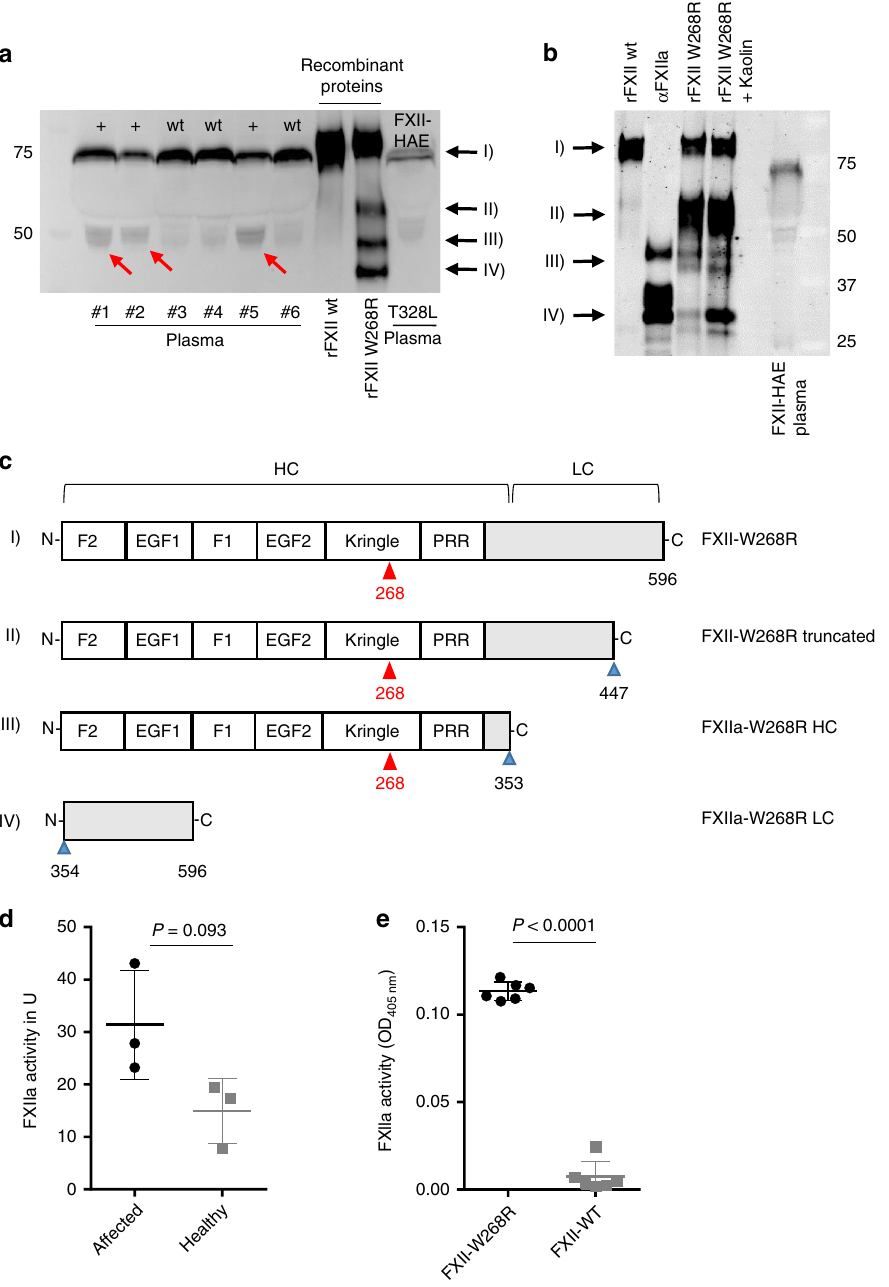
Fig. 2 FXII W268R results in fragmentation and spontaneous activation of FXII. a FXII fragmentation in FACAS plasma samples and FXII W268R mutant proteins. Citrate plasma of affected (#1, #2, #5) and non-affected (#3, #4, #6) family members, recombinant wild-type and W268R FXII expressed in HEK293 cells and plasma from an FXII-HAE patient was separated by SDS-PAGE (reducing blot) and immunoblotted for FXII. Red arrows at 50 kDa indicate heavy chain of cleaved FXII in the plasma of affected patients and recombinant W268R FXII (rFXII W268R), which is barely visible in non-affected and hereditary angioedema (HAE) III plasma or wild-type FXII (rFXII wt). Recombinant W268R and wild-type FXII were expressed in HEK293 cells. Black arrows point to rFXII W268R fragments observed by mass spectrometry in c , n = 5 technical replicates. b Immunoblot (reduced conditions) of recombinant mutant proteins (in the presence or absence of surface activator kaolin) and controls (rFXII wt and puri fi ed α FXIIa). In addition to 50 kDa (heavy chain, HC) and 25 kDa (light chain, LC) bands, a further band appears at 60 kDa (II) that is absent in rFXII wt and α FXIIa. Black arrows point to rFXII W268R fragments observed by mass spectrometry in c , n = 3 technical replicates. c Schematic presentation of FXII W268R procession. Red arrows point to mutation at position W268R. Proteolytic sites are indicated by blue arrows. Cleavage after position 353 results in FXIIa W268R HC (50 kDa) and FXIIa W268R LC (25 kDa) fragments. Additional cleavage results in a truncated FXII W268R fragment (60 kDa) cleaved at position 447. d FXIIa activity was measured by a chromogenic assay demonstrating considerable spontaneous FXIIa activity in plasma of affected individuals ( n = 3), but less in healthy donors ( n = 3 healthy family members). e Spontaneous FXIIa activity was also observed in culture supernatants from HEK293 cells expressing W268R, but not wild-type FXII. Graphs show individual data points and the mean ± s.e.m. Statistical signi fi cance is indicated by unpaired Student ’ s t test with Welch ’ s correction ( d , e ). Source data are provided as a source data fi